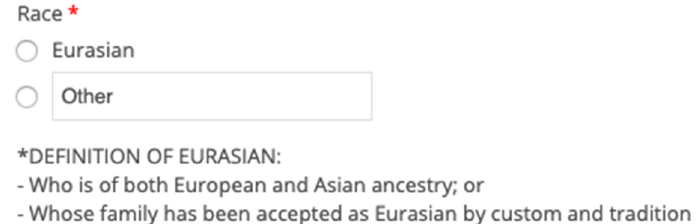
Figure 1. Race Question for Membership of the EA, from http://www.eurasians.org.sg/, accessed on 26 August 2019.